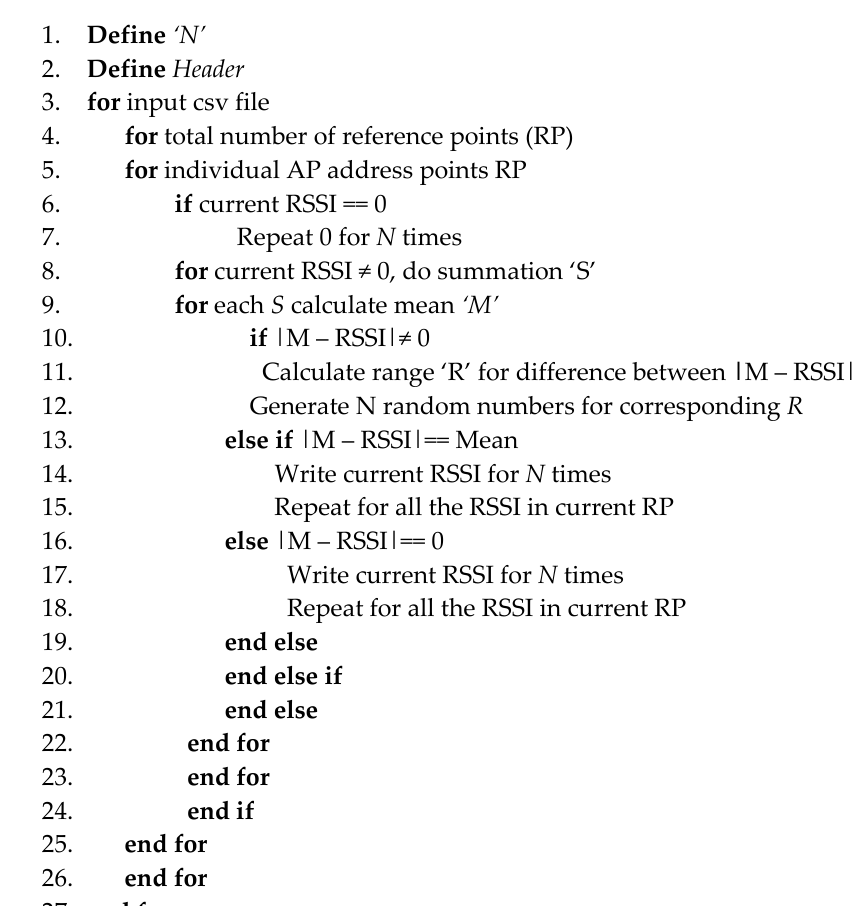
Scheme 2. Pseudocode for data augmentation with mean and uniform random